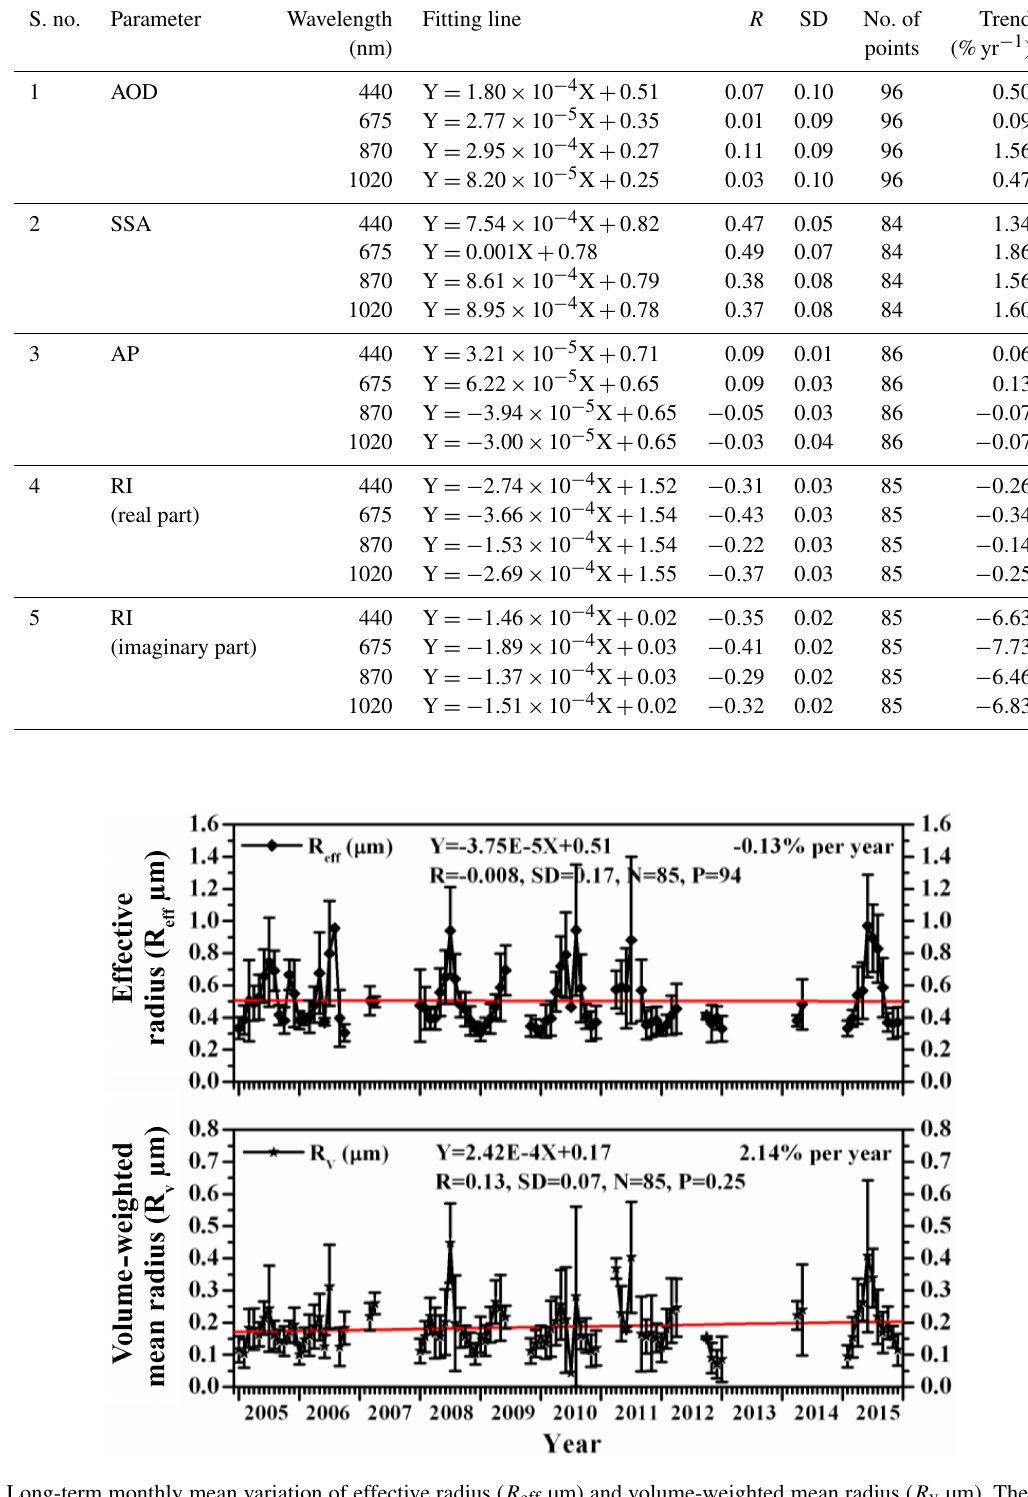
Table 2. Statistical information on the trend analysis of different aerosol products. S. no.